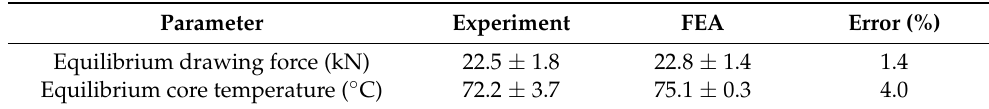
Table 2. Comparison of equilibrium drawing force and core temperature between experiment and FEA.